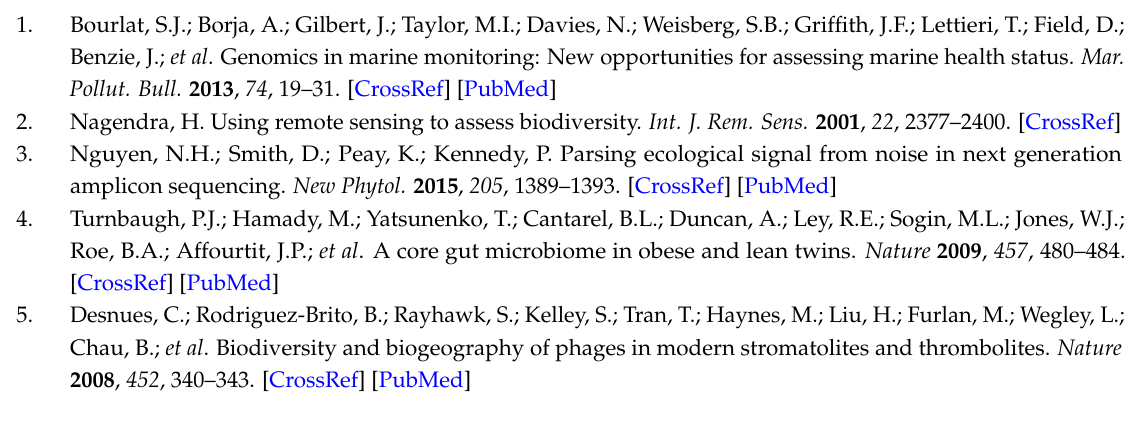
Figure S1: Distribution of the number of haplotypes for each combination of theta (two, ten, twenty) and sampling size (2, 4, 8, 16, 32, 64, 128). Figure S2: Distribution of the number of segregating sites for each combination of theta (two, ten, twenty) and sampling size (2, 4, 8, 16, 32, 64, 128). Figure S3: Probability distribution of the number of individuals back calculated using the gamma approach. Each panel shows a combination of simulated sampling size and the mutation rate in the original populations. Appendix S1: R code to simulate populations and estimate genetic diversity